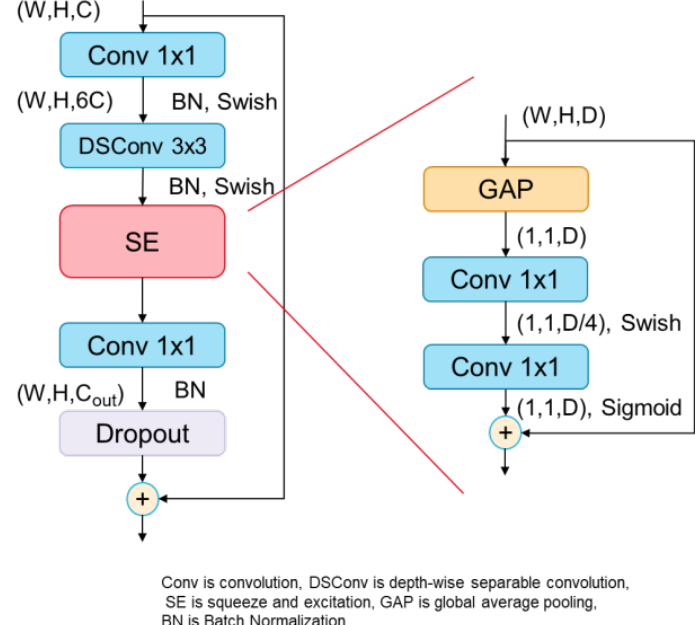
Figure 5. MBConv